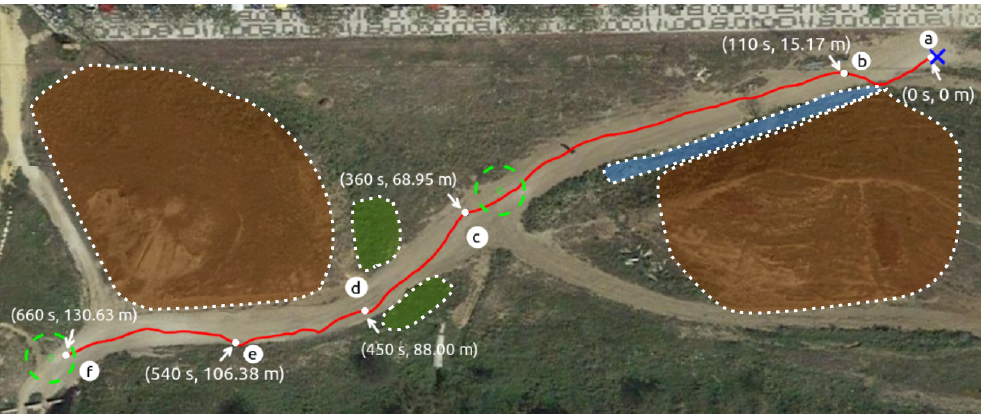
Figure 18. Path followed by Andabata with indications of traveled distance and elapsed time. Shadowed areas in brown, green and blue colors represent hills, weeds and ditches, respectively.